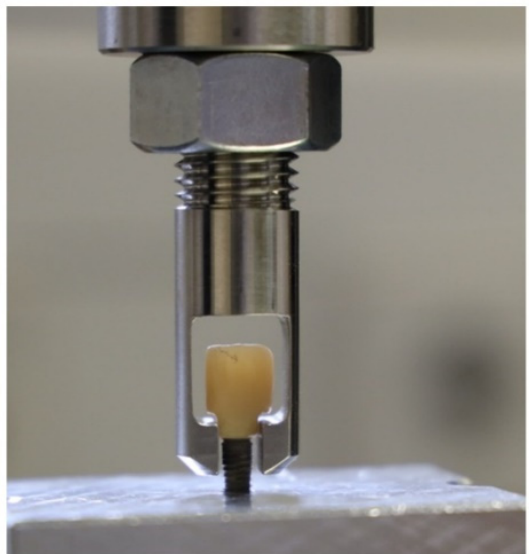
Figure 7. Mounting of the samples in the universal testing machine and with the pull-off force clamp in situ.